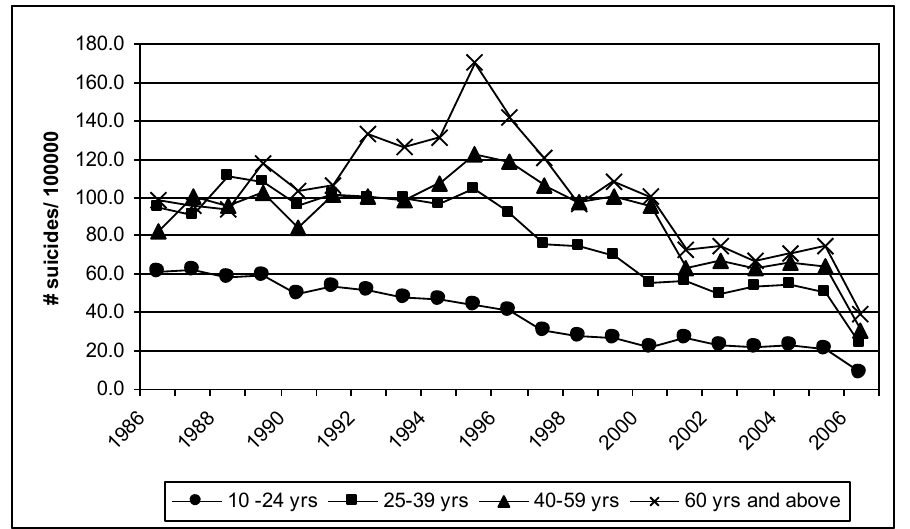
Source: Department of Police, Sri